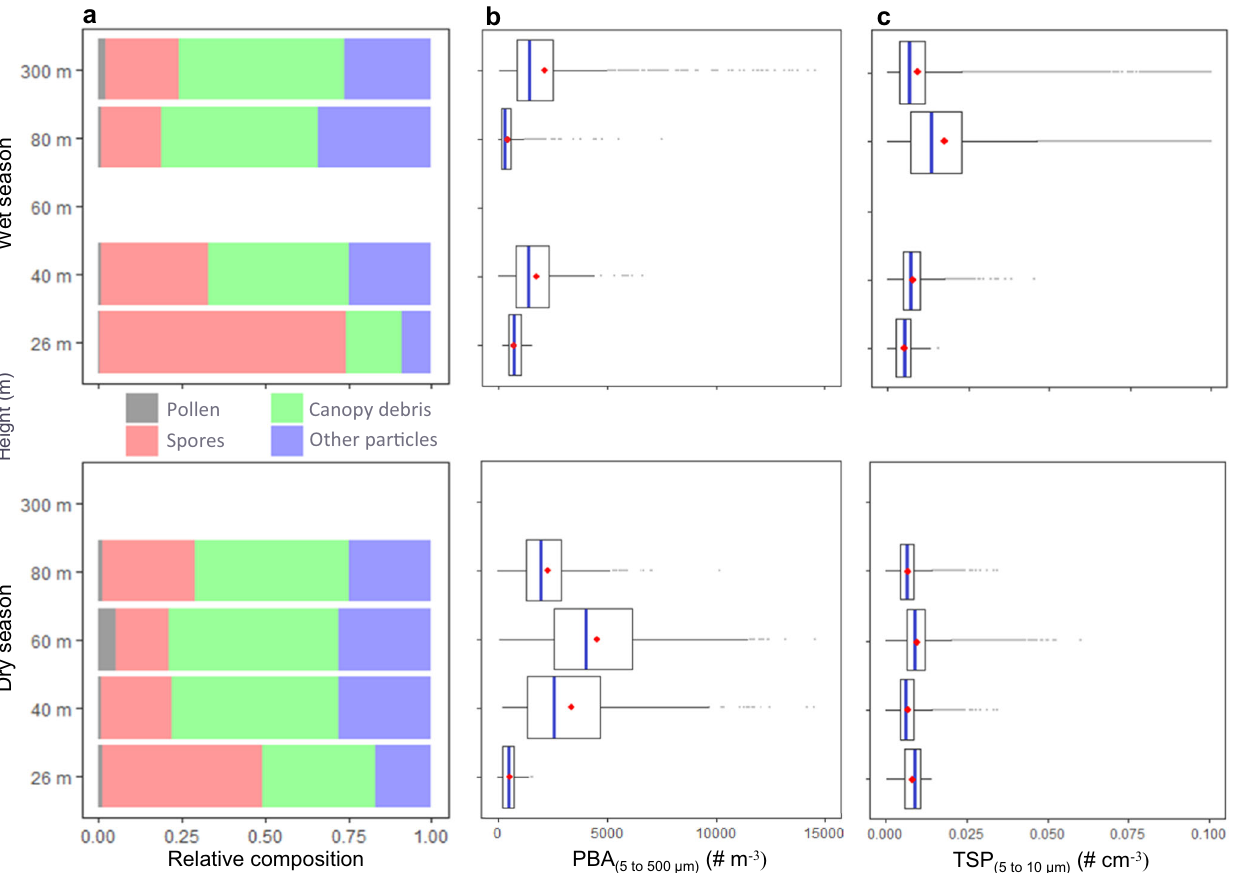
Fig. 4 General seasonal distribution and particle quanti fi cation per height and season (wet season: top, dry season: bottom). a Relative composition of all sampled particles per height and season presenting the main categories: pollen, all spores, canopy debris and other particles in gray, red, green and blue respectively; b PBA (5 to 500 µm) concentration (# m − 3 ) as boxplots for each height and season with the box for 1st and 3rd quartiles, median as a blue line and mean as the red dot, 5 and 95 percentiles as whiskers, outliers marked as gray dots; c total suspended particle concentration in the range from (5 to 10 µm) (# m − 3 ) also shown for each height and level, with the presence of more outliers during the wet season for the highest